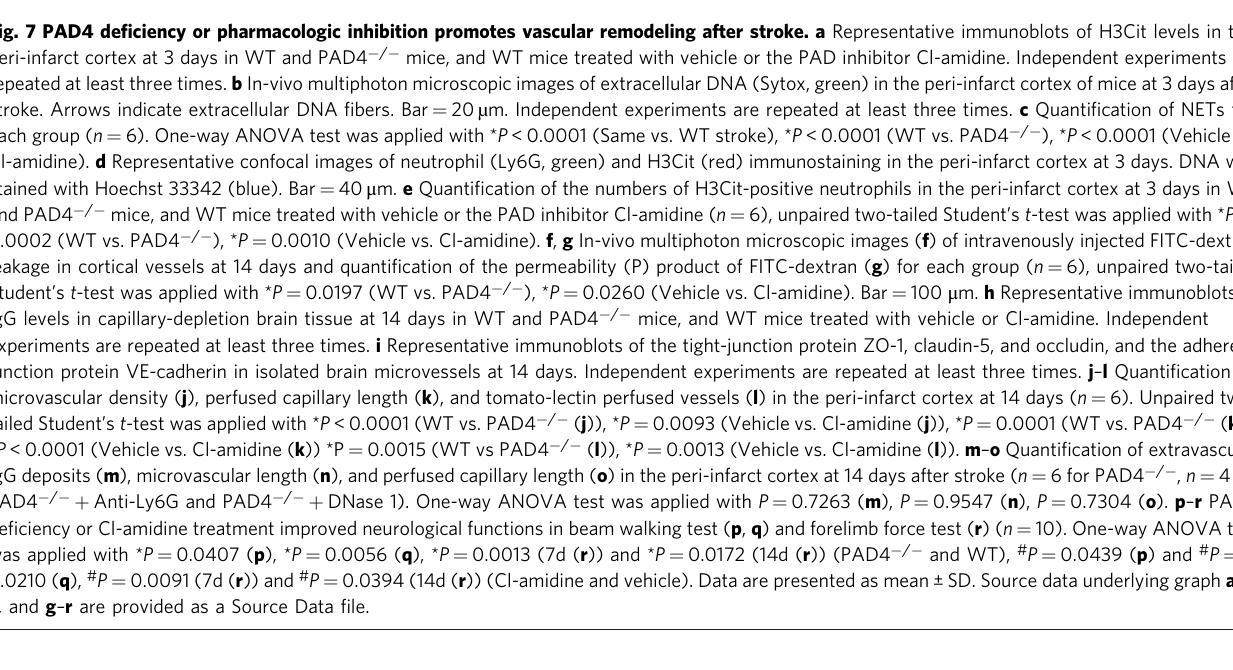
Fig. 7 PAD4 de fi ciency or pharmacologic inhibition promotes vascular remodeling after stroke. a Representative immunoblots of H3Cit levels in the peri-infarct cortex at 3 days in WT and PAD4 − / − mice, and WT mice treated with vehicle or the PAD inhibitor Cl-amidine. Independent experiments are repeated at least three times. b In-vivo multiphoton microscopic images of extracellular DNA (Sytox, green) in the peri-infarct cortex of mice at 3 days after stroke. Arrows indicate extracellular DNA fi bers. Bar = 20 µ m. Independent experiments are repeated at least three times. c Quanti fi cation of NETs for each group ( n = 6). One-way ANOVA test was applied with * P < 0.0001 (Same vs. WT stroke), * P < 0.0001 (WT vs. PAD4 − / − ), * P < 0.0001 (Vehicle vs. Cl-amidine). d Representative confocal images of neutrophil (Ly6G, green) and H3Cit (red) immunostaining in the peri-infarct cortex at 3 days. DNA was stained with Hoechst 33342 (blue). Bar = 40 μ m. e Quanti fi cation of the numbers of H3Cit-positive neutrophils in the peri-infarct cortex at 3 days in WT and PAD4 − / − mice, and WT mice treated with vehicle or the PAD inhibitor Cl-amidine ( n = 6), unpaired two-tailed Student ’ s t -test was applied with * P = 0.0002 (WT vs. PAD4 − / − ), * P = 0.0010 (Vehicle vs. Cl-amidine). f , g In-vivo multiphoton microscopic images ( f ) of intravenously injected FITC-dextran leakage in cortical vessels at 14 days and quanti fi cation of the permeability (P) product of FITC-dextran ( g ) for each group ( n = 6), unpaired two-tailed Student ’ s t -test was applied with * P = 0.0197 (WT vs. PAD4 − / − ), * P = 0.0260 (Vehicle vs. Cl-amidine). Bar = 100 μ m. h Representative immunoblots of IgG levels in capillary-depletion brain tissue at 14 days in WT and PAD4 − / − mice, and WT mice treated with vehicle or Cl-amidine. Independent experiments are repeated at least three times. i Representative immunoblots of the tight-junction protein ZO-1, claudin-5, and occludin, and the adherens junction protein VE-cadherin in isolated brain microvessels at 14 days. Independent experiments are repeated at least three times. j – l Quanti fi cation of microvascular density ( j ), perfused capillary length ( k ), and tomato-lectin perfused vessels ( l ) in the peri-infarct cortex at 14 days ( n = 6). Unpaired two- tailed Student ’ s t -test was applied with * P < 0.0001 (WT vs. PAD4 − / − ( j )), * P = 0.0093 (Vehicle vs. Cl-amidine ( j )), * P = 0.0001 (WT vs. PAD4 − / − ( k )), * P < 0.0001 (Vehicle vs. Cl-amidine ( k )) *P = 0.0015 (WT vs PAD4 − / − ( l )), * P = 0.0013 (Vehicle vs. Cl-amidine ( l )). m – o Quanti fi cation of extravascular IgG deposits ( m ), microvascular length ( n ), and perfused capillary length ( o ) in the peri-infarct cortex at 14 days after stroke ( n = 6 for PAD4 − / − , n = 4 for PAD4 − / − + Anti-Ly6G and PAD4 − / − + DNase 1). One-way ANOVA test was applied with P = 0.7263 ( m ), P = 0.9547 ( n ), P = 0.7304 ( o ). p – r PAD4 de fi ciency or Cl-amidine treatment improved neurological functions in beam walking test ( p , q ) and forelimb force test ( r ) ( n = 10). One-way ANOVA test was applied with * P = 0.0407 ( p ), * P = 0.0056 ( q ), * P = 0.0013 (7d ( r )) and * P = 0.0172 (14d ( r )) (PAD4 − / − and WT), # P = 0.0439 ( p ) and # P = 0.0210 ( q ), # P = 0.0091 (7d ( r )) and # P = 0.0394 (14d ( r )) (Cl-amidine and vehicle). Data are presented as mean ± SD. Source data underlying graph a , c , e , and g – r are provided as a Source Data fi